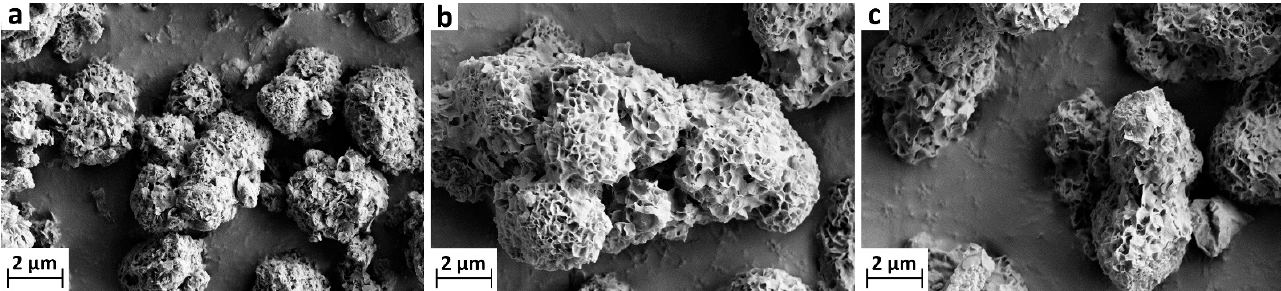
Figure 2. Scanning electron microscope (SEM) images of modified calcium carbonate (MCC) at 7500× magnification: ( a ) unloaded MCC, ( b ) MCC loaded with linoleic acid (20 wt%) and ( c ) MCC loaded with oleic acid (20 wt%).